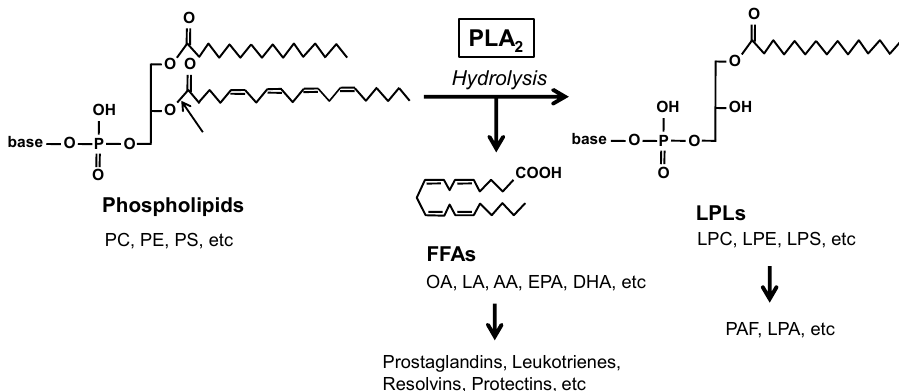
Figure 1. Phospholipase A 2 (PLA 2 ) reaction. PLA 2 enzymes hydrolyze the sn -2 position of phospho- lipids (arrow) to generate free fatty acids (FFAs) and lysophospholipids (LPLs). AA, arachidonic acid; DHA, docosahexaenoic acid; EPA, eicosapentaenoic acid; LA, linoleic acid; LPA, lysophospha- tidic acid; LPC, lysophosphatidylcholine; LPE, lysophosphatidylethanolamine; LPS, lysophospha- tidylserine; OA, oleic acid; PAF, platelet-activating factor; PC, phosphatidylcholine; PE, phosphati- dylethanolamine; PS, phosphatidylserine.